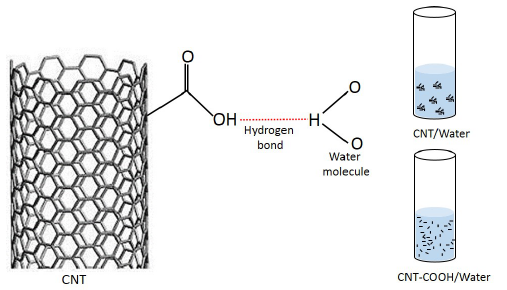
Figure 1. Hydrogen bonding between the CNT-COOH and